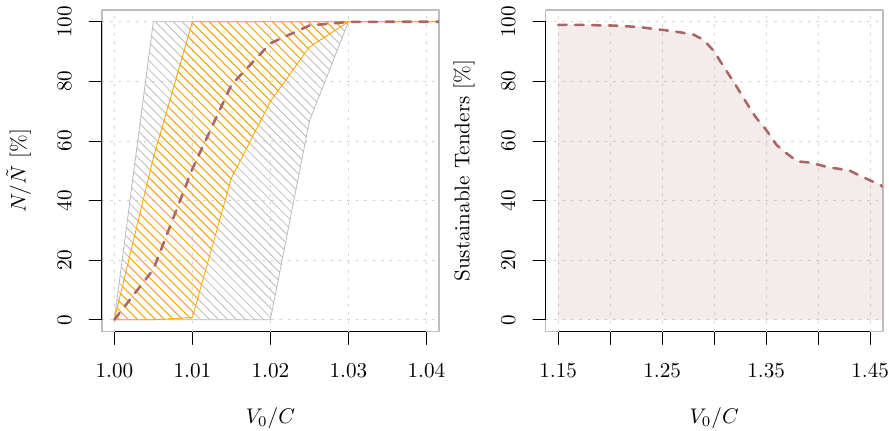
Figure 7. Sustainability as a function of the starting price V 0 . Left panel : fraction of constructors who can afford to make a bid, as the starting price approaches the breakeven level C ( dashed line : average; orange area : confidence interval within 1 standard deviation; grey area : confidence level within ± 0.01–0.99 quantiles). Right panel : fraction of concluded tenders whose requested performance bond is not rejected by the surety (average level) at increasing starting